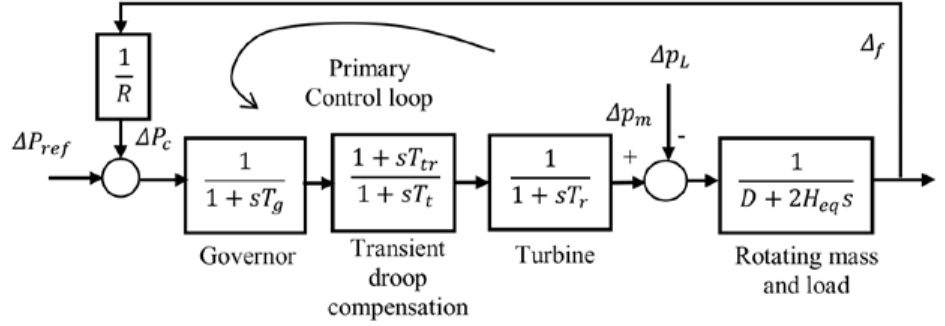
Figure 6. Simplified load frequency control model, adapted from [31].